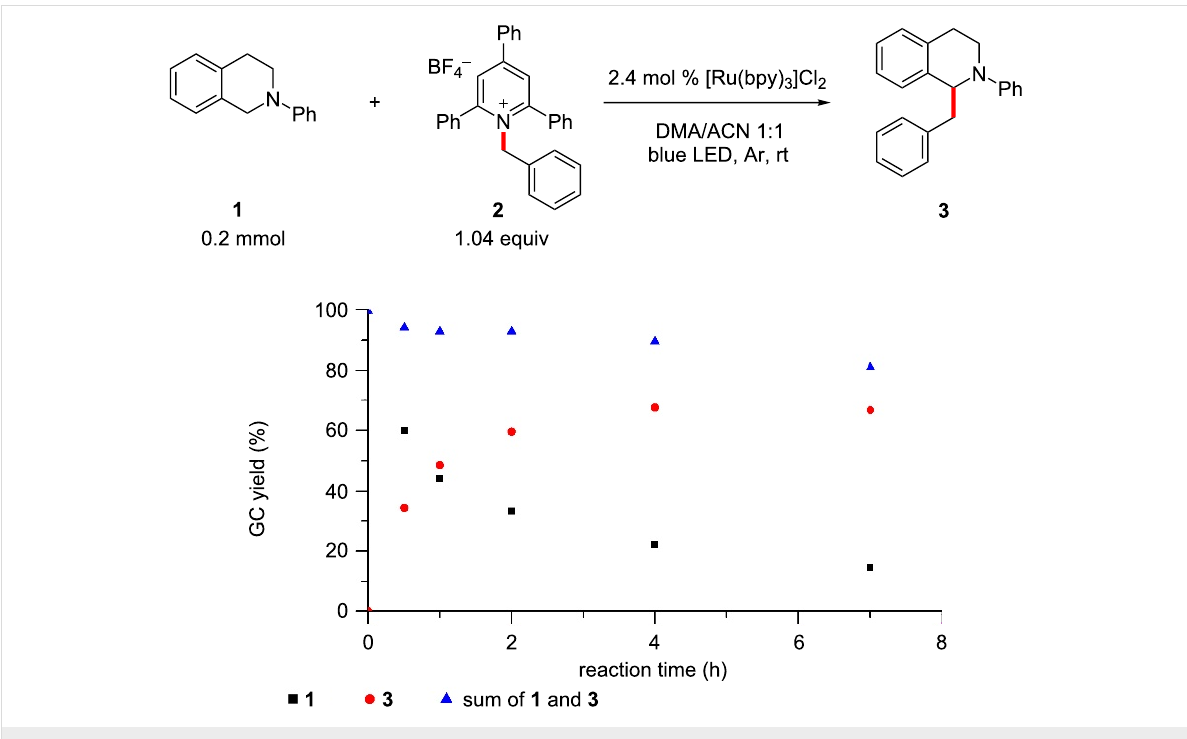
Figure 1: Kinetic profile for the benzylation of 1 to 3